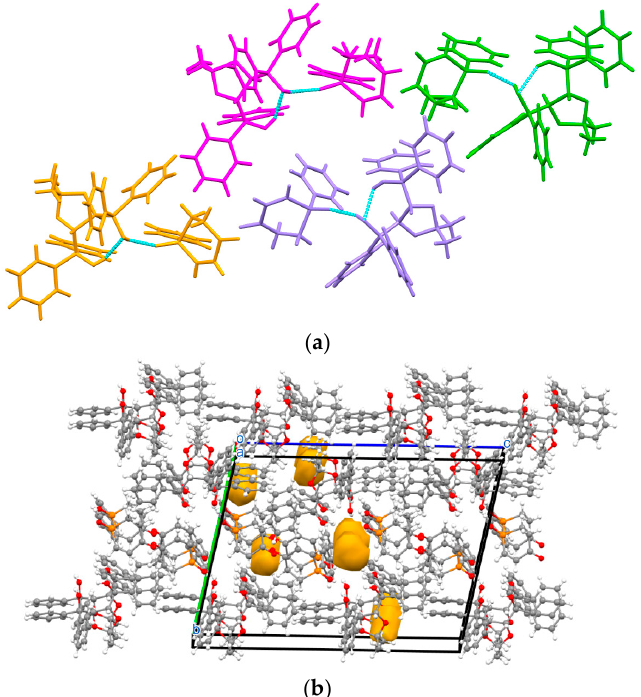
Figure 5. View of ( S )- 2 •( R,R )-TADDOL: ( a ) the symmetrically independent part (Z’ = 4) of the crystal and ( b ) empty voids (1.3% of unit cell volume) in the crystal structure.